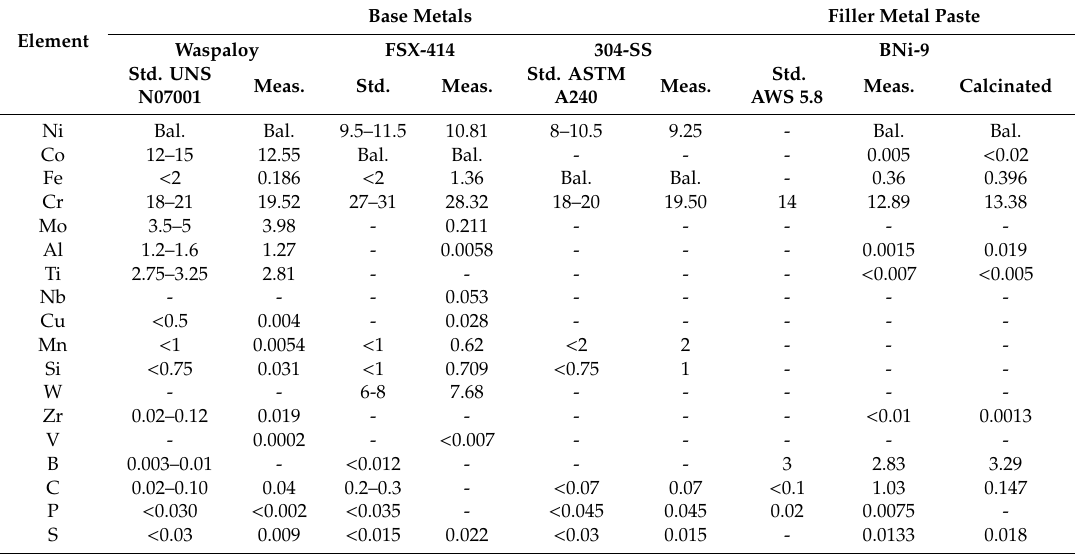
Table 2. Chemical composition (wt. %) of base metals and filler metal paste. Element